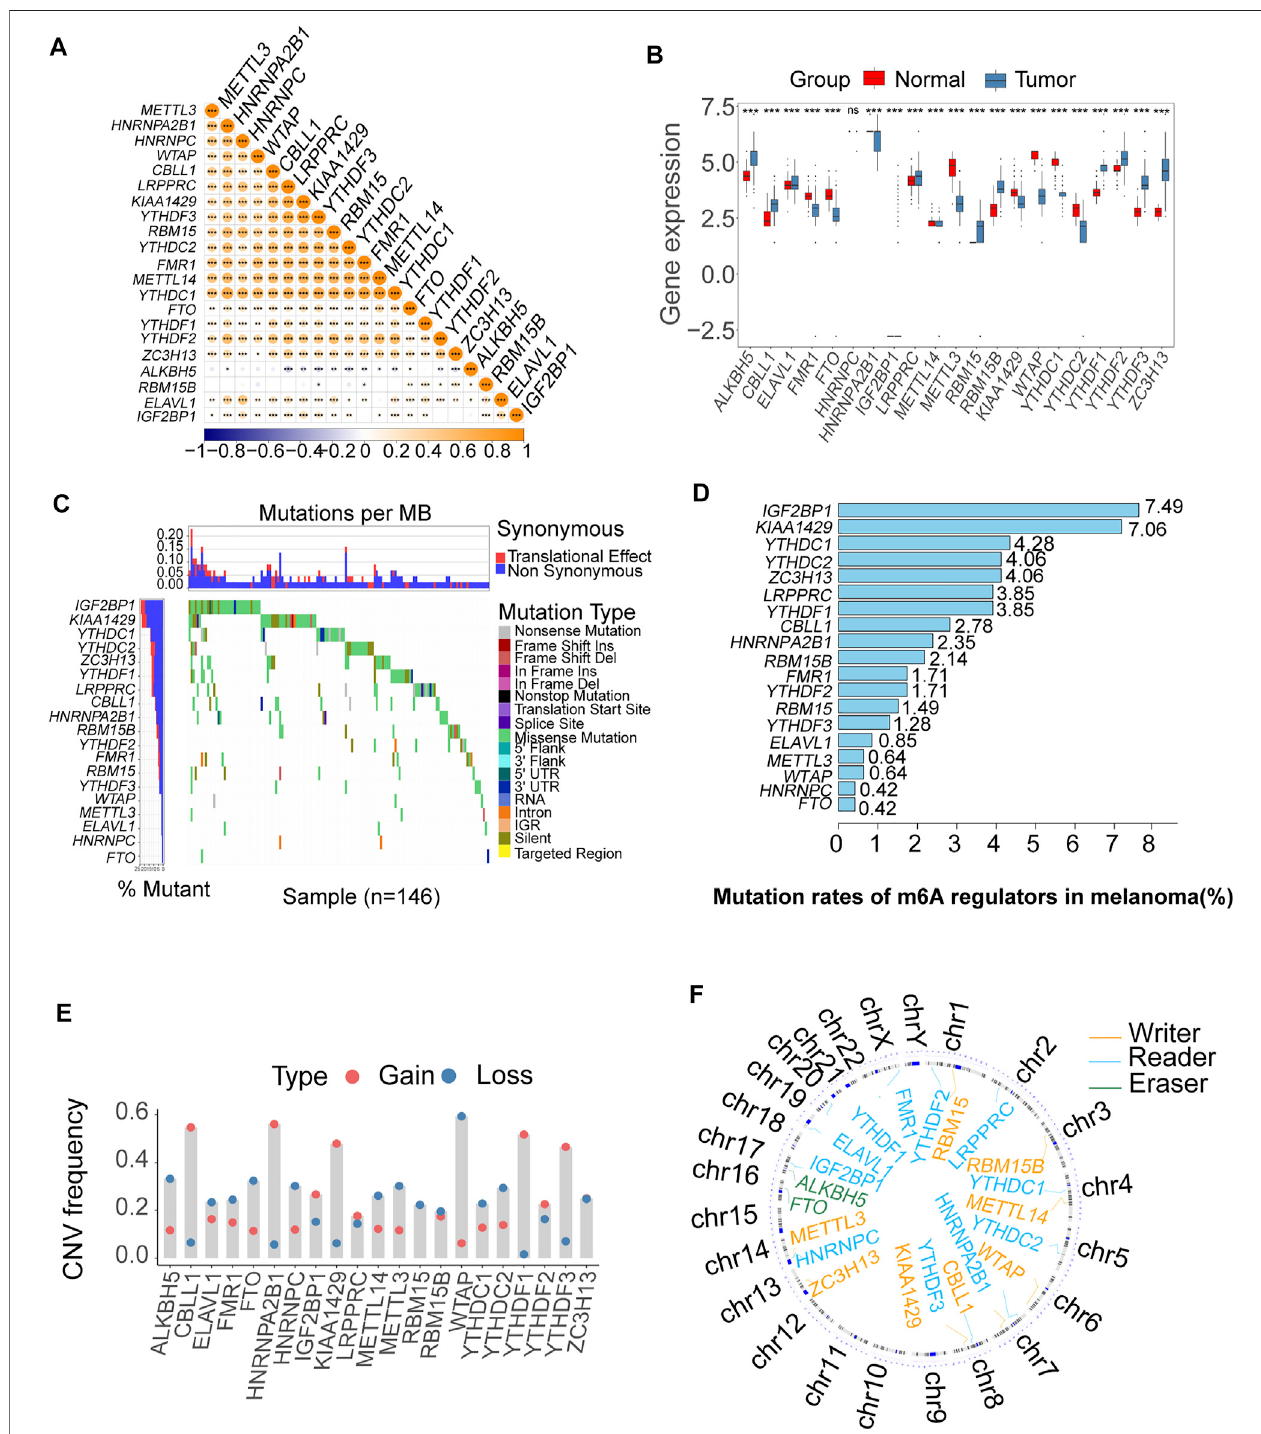
FIGURE 2 | Bioinformatics analysis of the expression and genetic variation of m6A regulators in melanoma. (A) The expression correlation of m6A regulators; blue represents negative correlation, and orange represents positive correlation (* p < 0.05, ** p < 0.01, *** p < 0.001). (B) The box plots were used to visualize the differential expression of 21 m6A regulators in tumor and normal samples; the expression values are log-transformed (* p < 0.05, ** p < 0.01, *** p < 0.001). (C) Waterfall diagram of the m6A regulators in the TCGA melanoma cohort. Each column represented individual patients. The upper barplot showed TumorMutationBurden (TMB). The number on the left indicated the mutation frequency in each gene. (D) This bar graph displays the mutation rates of m6A regulators in TCGA melanoma. (E) The CNV alteration of the 21 m6A regulators. (F) The position of the CNV variation in the chromosome of these m6A regulators.